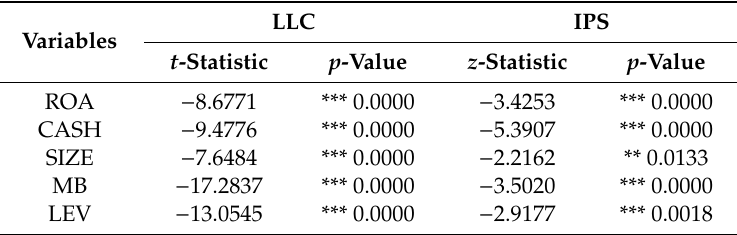
Table 2. Unit root test